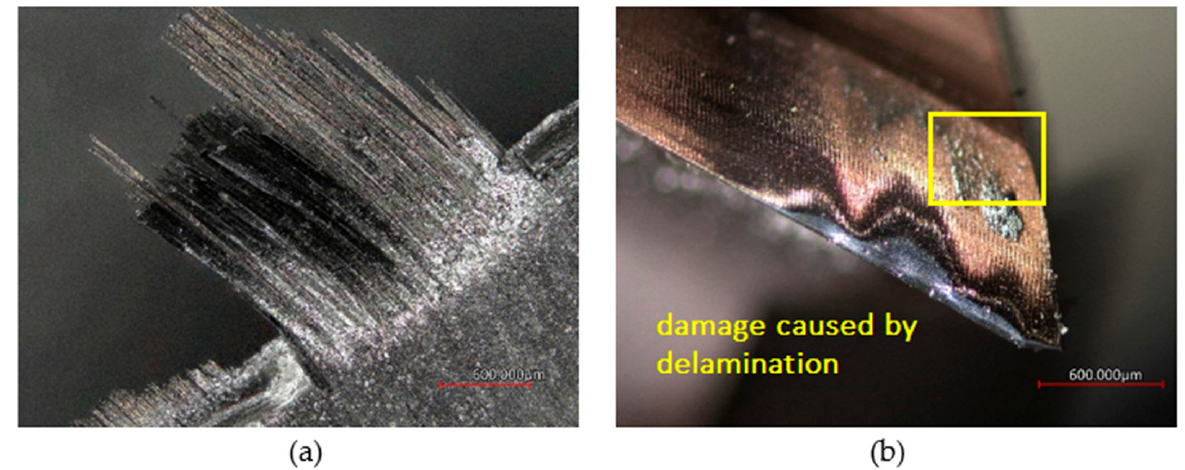
Figure 7. Capture after a tool tooth path of 15 × 165 m. ( a ) Laminate thickness 1 mm; ( b ) G550 milling tool.